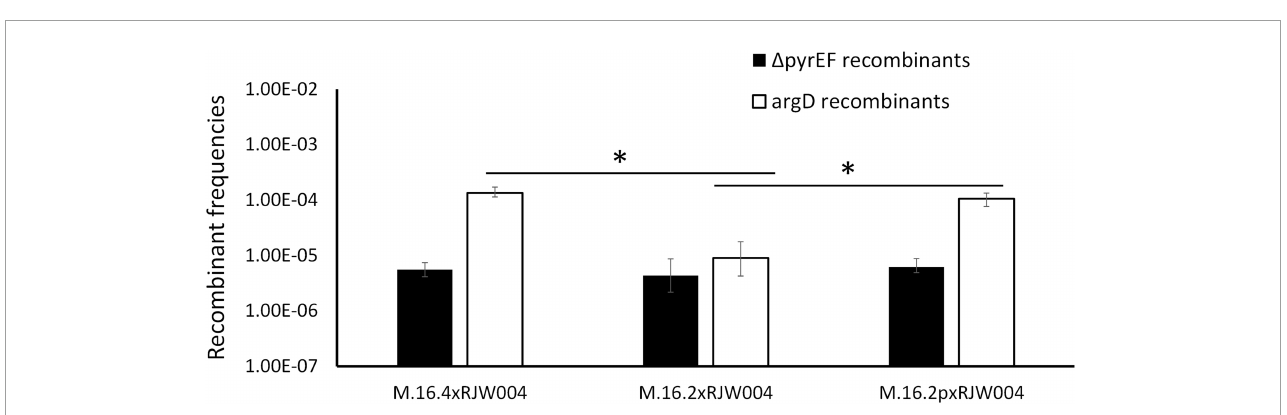
FIGURE5 Recombination frequencies of genetic markers in M.16.2 transconjugant mating assays compared to parent strain. White bars represent the recombinant frequency of argD , while black bars represent the recombinant frequency of (cid:49) pyrEF . Error bars represent highest and lowest replicate for each assay, ∗ represents a p -value of < 0.05 when comparing to M.16.2 argD